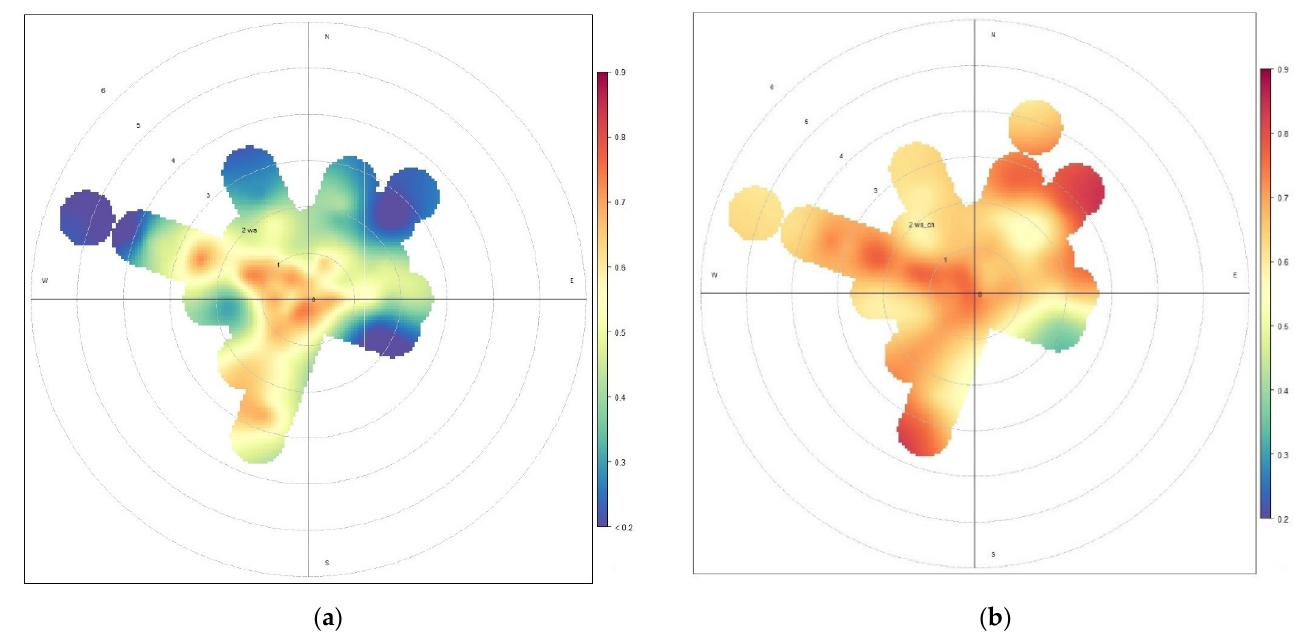
Figure 8. ( a ) Polarplot of the PM2.5/PM10 ratio at TH, 2017–2018. ( b ) Polarplot of the PM2.5/PM10 ratio at CH, 2017–2018.